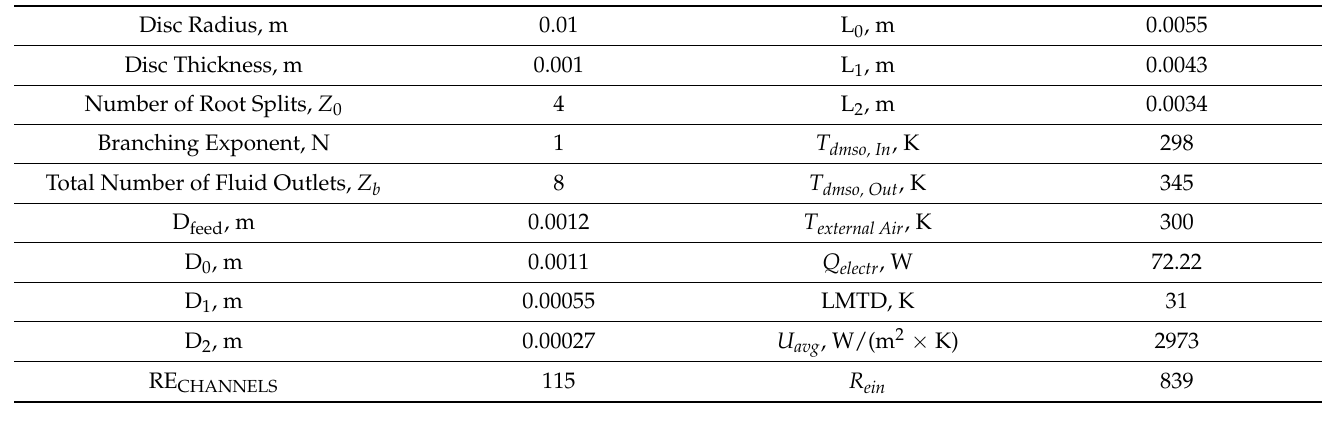
Table 5. Improved design of the ultra-micro DSHE.